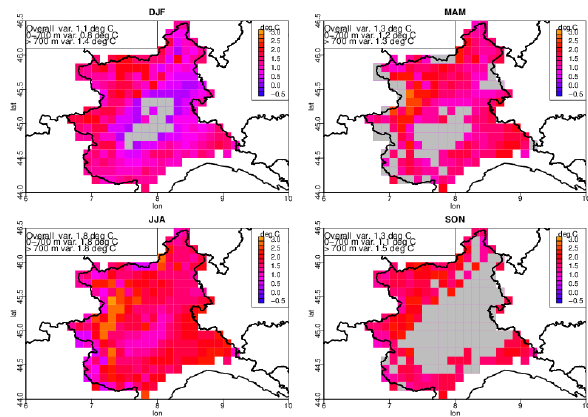
Figure 10: difference between the Multimodel SuperEnsemble scenario minimum temperatures averaged over the period 2031-2050 with respect to the period 1981-2000, as a function of the season (T-test conf. level 95%) in Piemonte region. In the upper left boxes overall averages over significant points and altitude bands averages are shown.